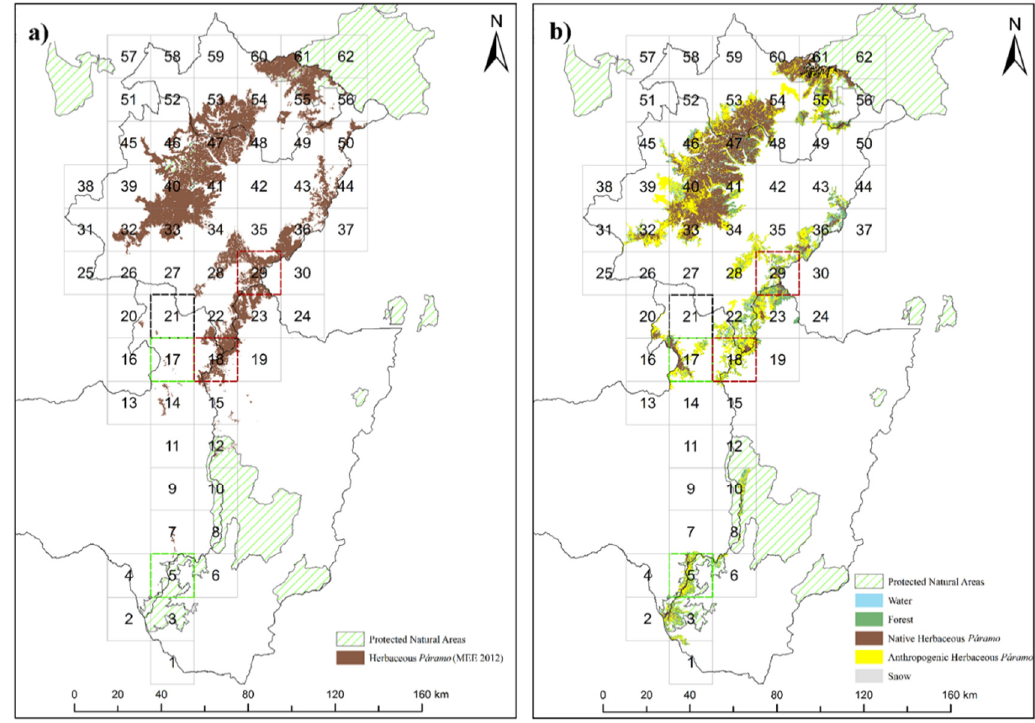
Figure 5. ( a ) The native herbaceous páramo reported in Ecuador’s ecosystem map [20]. ( b ) The native herbaceous páramo and anthropogenic herbaceous páramo predicted by the classification decision tree in the study area.